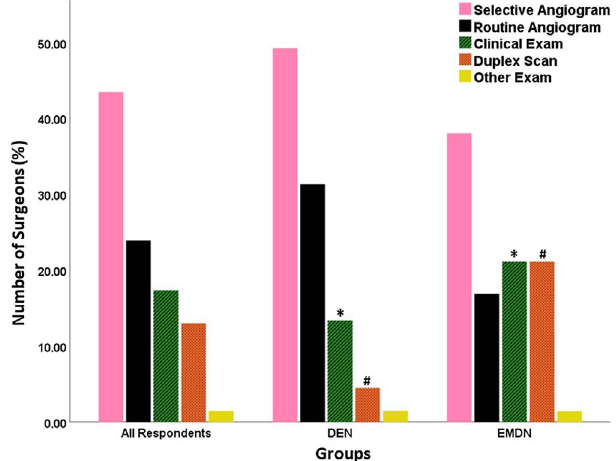
Figure 4. Various vascular examinations that were reported to be performed by the participating surgeons. Signi fi cant differences are denoted by * and